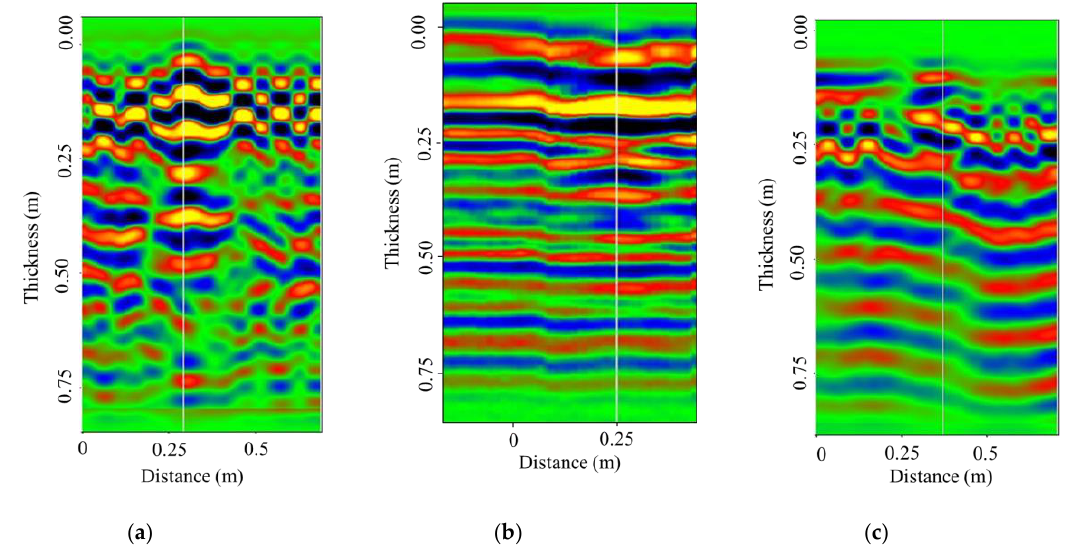
Figure 9. The different conditions of grouting holes obtained from field detection: ( a ) empty; ( b ) filled with water; ( c ) filled with grout.